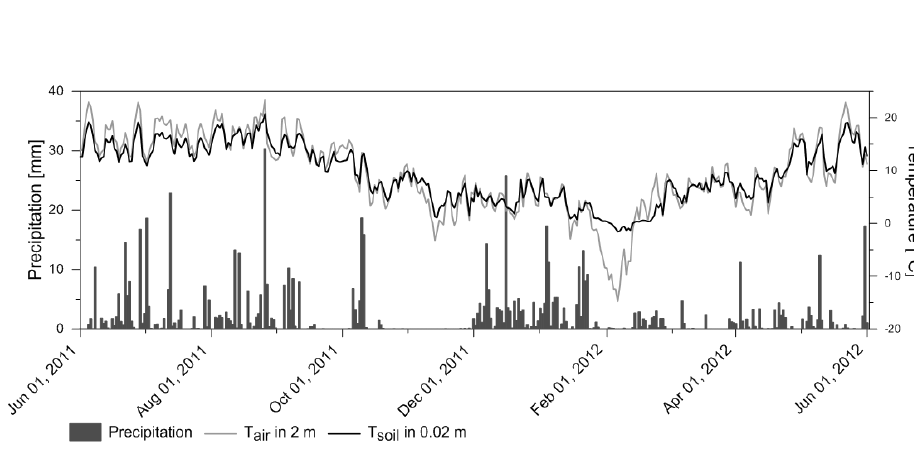
Fig. 1. Time series of precipitation, air, and 2cm soil temperature at the meteorological